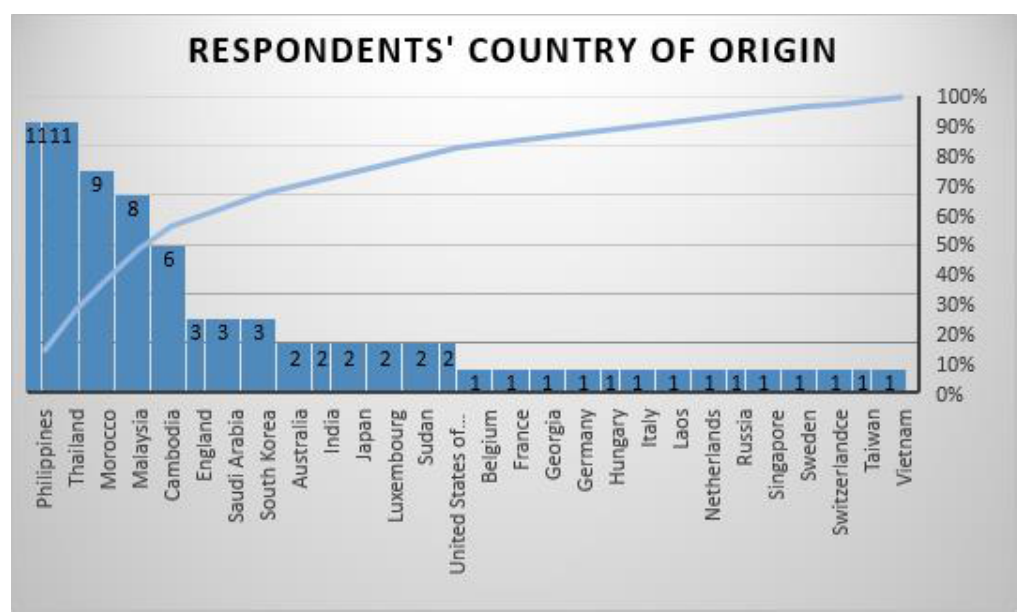
Figure 2. Profil Respondents’ Country of Origin